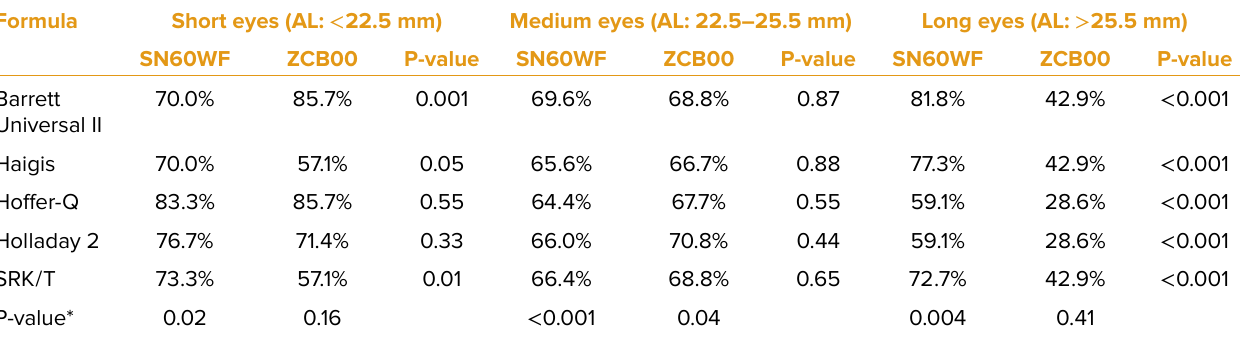
Table 5. Percentage of eyes within ± 0.5 D of the predicted refraction for SN60WF and ZCB00 lenses for short, medium, and long